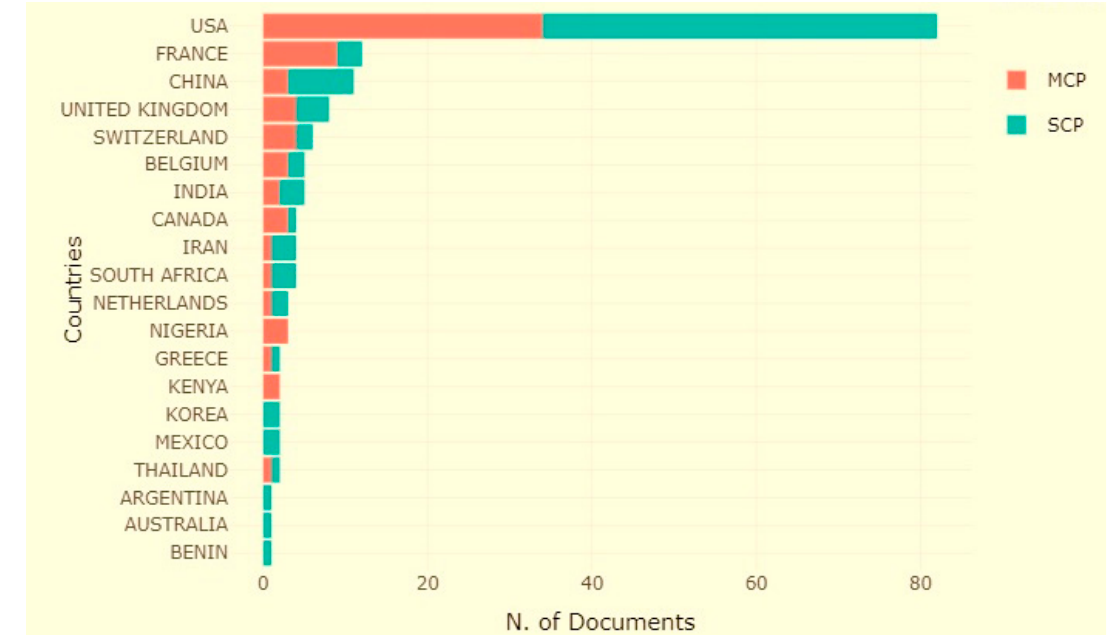
Figure 6. Corresponding author’s country affiliation; (MCP = inter-country collaboration index; SCP = intra-country collaboration). SCP = intra-country